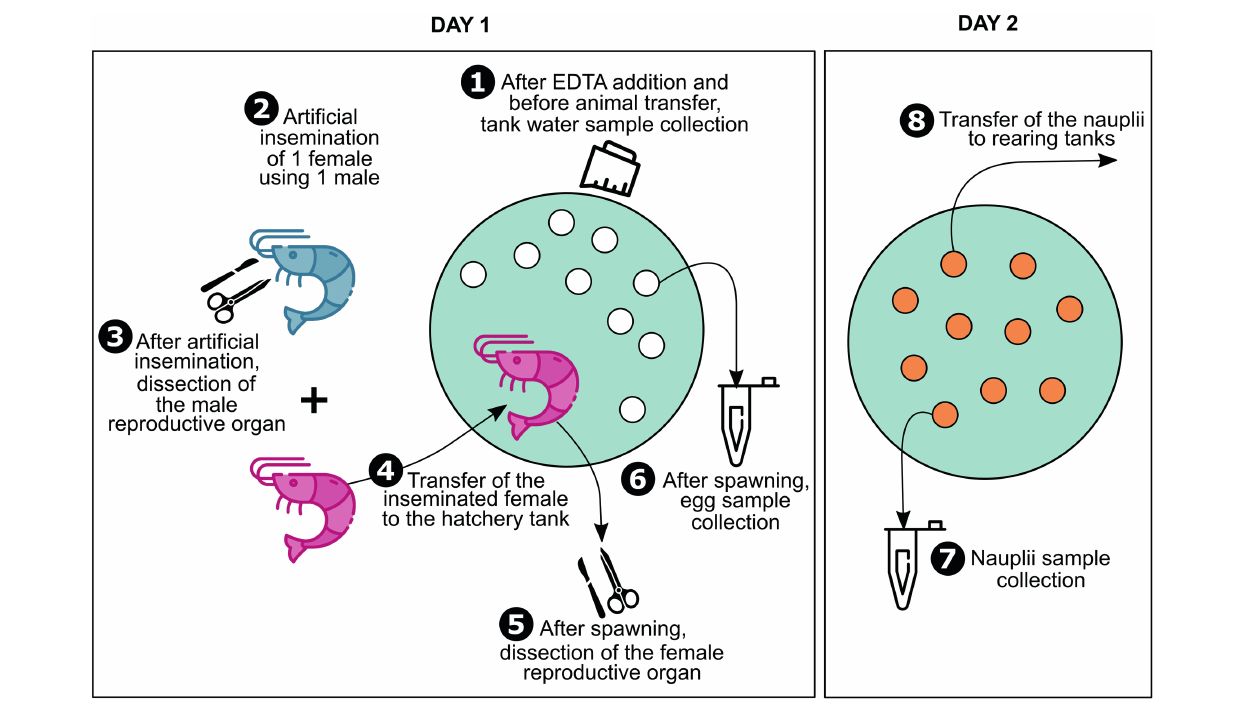
FIGURE 1 | Sample collection. Sample collection was performed using an eight-steps technique. First, water was sampled from the hatchery tanks after ethylenediaminetetraacetic acid (EDTA) addition. Then, on the day the tanks were filled and sampled, artificial inseminations were performed. In order to consider two-parent families only, one male was used to inseminate one female for all the artificial inseminations. After artificial inseminations, males were dissected in order to sample their reproductive organ and females were transferred into the hatchery tanks at a rate of 1 individual per tank and were left to spawn. After spawning, females were retrieved to dissect their ovarian tissue, and eggs were sampled from all the hatchery tanks. To allow larval hatching, eggs were left until the next day in the hatchery tanks. Before transfer into rearing tanks, the nauplii were sampled from each tank. A total of three two-parent families were considered for this